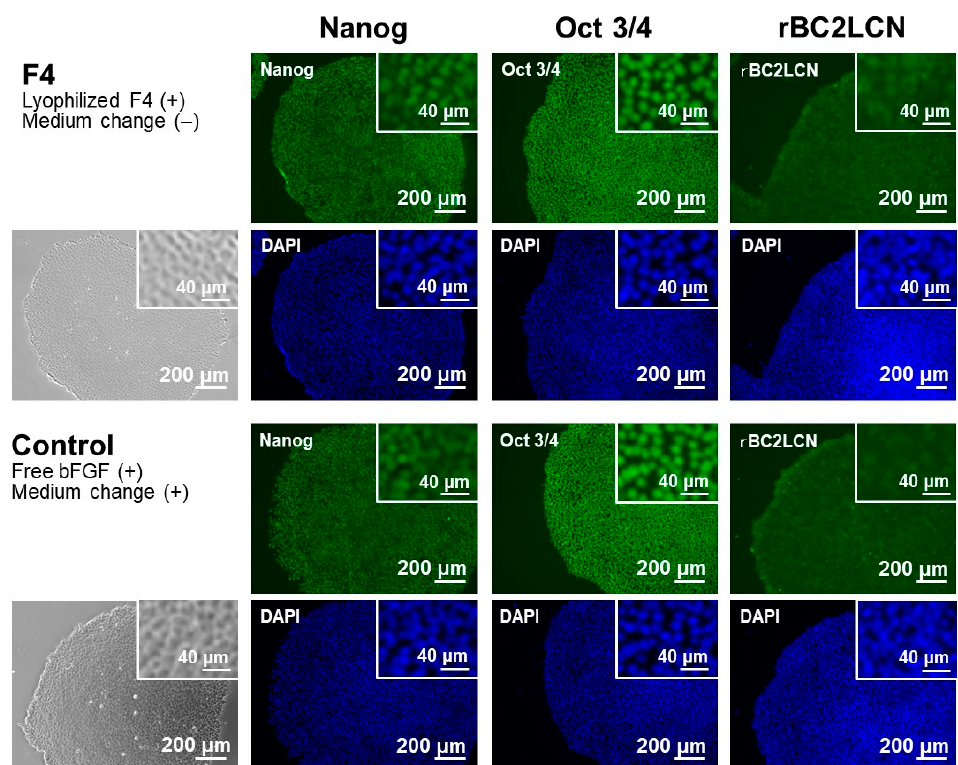
Figure 6. Concentrations of bFGF in the culture medium of human iPSCs, on Day 3 in repeated (up to 5 times) cycles of the medium-change-free continuous culture with the lyophilized F4 mem- brane (F4 group; gray bars) or of standard culture using bFGF-containing medium with daily me- dium refreshment (control group; white bars) (average + SD; n = 3; * p < 0.05).